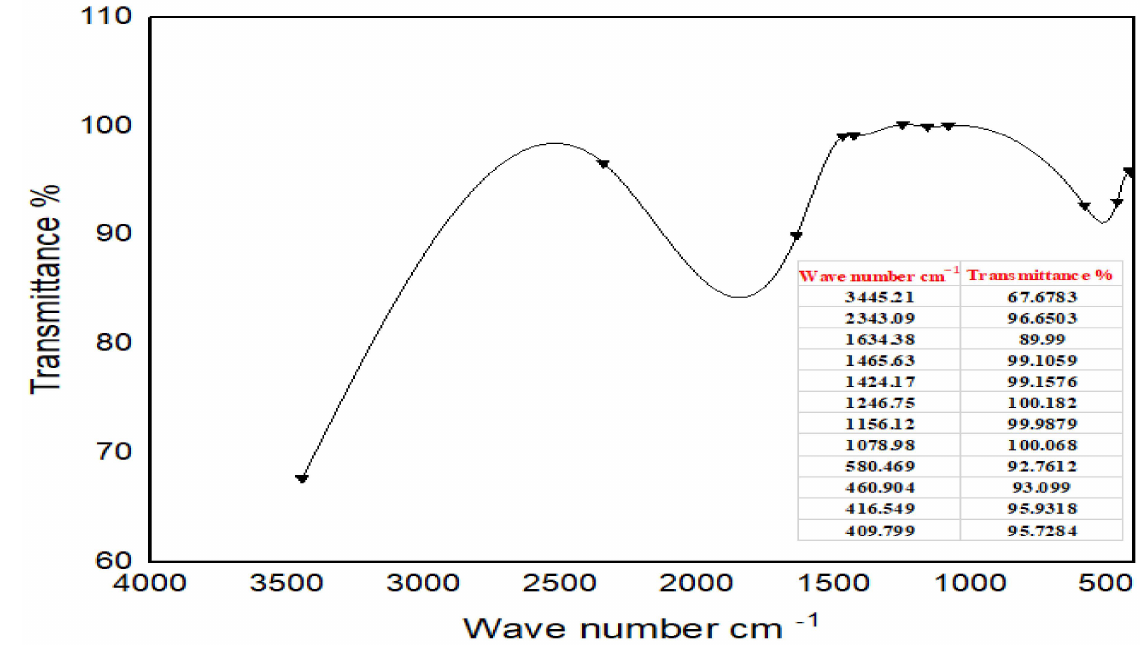
Figure 3. FTIR spectra of Moringa crude aqueous extract.